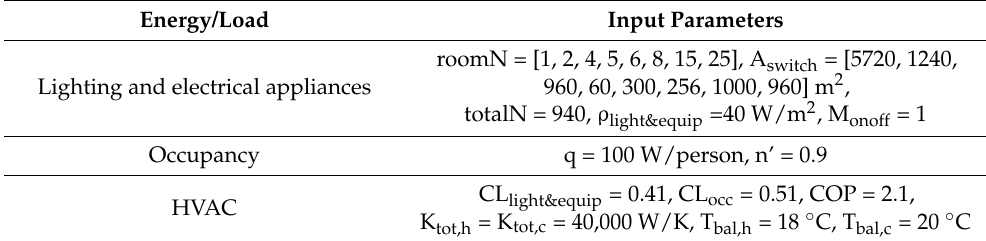
Table 4. Basic input parameters used in the case study.